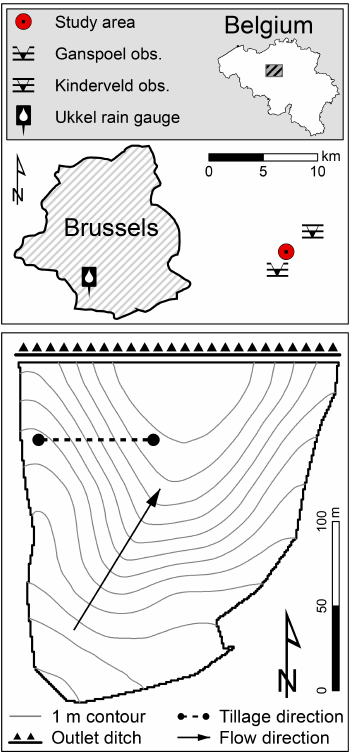
Figure 1. Topography and location of the test catchment, location of the Ganspoel and Kinderveld runoff and sediment observation stations and the rain gauge of Ukkel, Brussels-Capital Region.